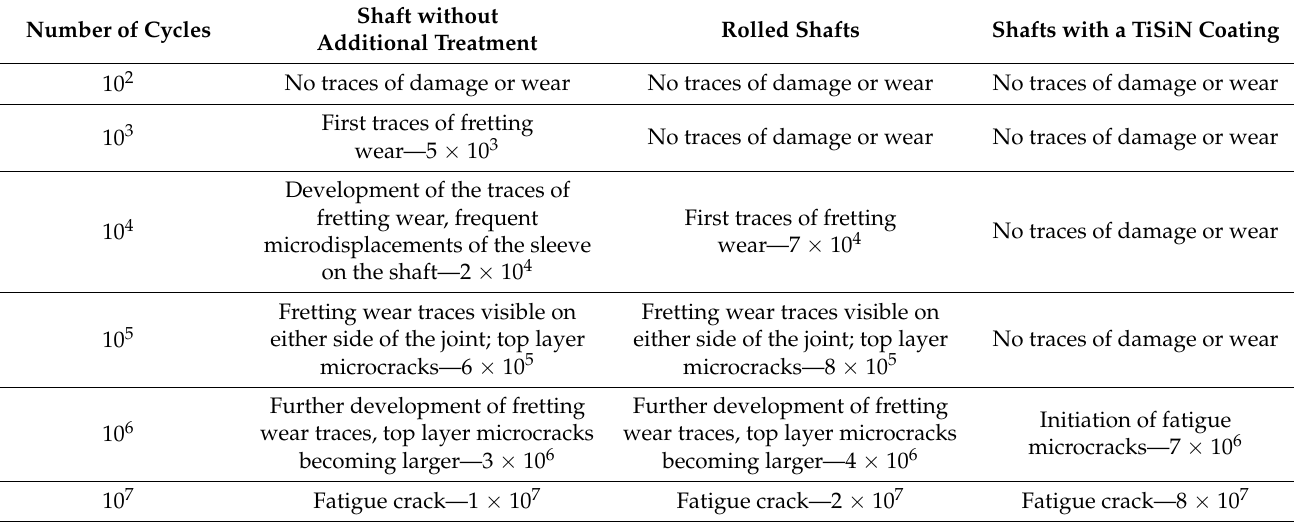
Table 7. List of the kinds of damage in relation to the number of fatigue